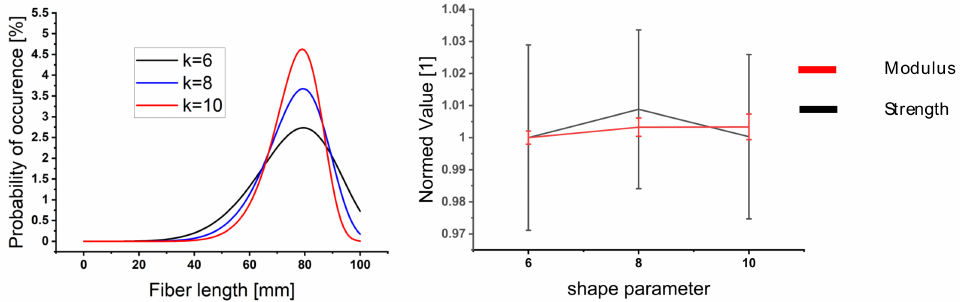
Figure 16. Parameter study of fiber length influence on composite properties ( left —probability density functions of Weibull distribution, right —influence of Weibull shape parameter on composite